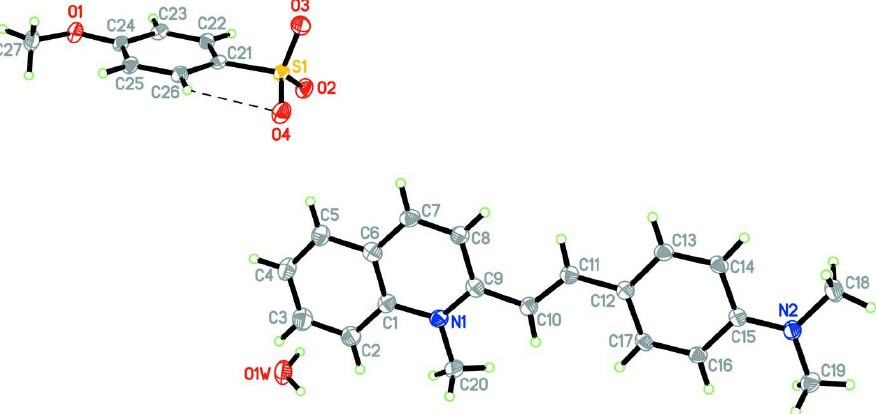
The asymmetric unit of (I) showing 50% probability displacement ellipsoids and the atom-numbering scheme. The weak intramolecular C—H···O interaction is drawn as a dashed